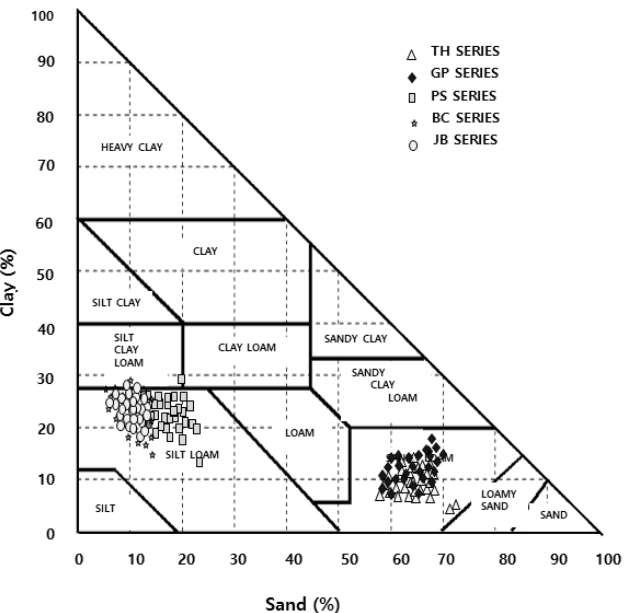
Figure 3. Soil textural distribution of the data set used for estimating the PTFs for five soil series in the RTFS. TH, Taeahn soil series; GP, Gwangpo soil series; PS, Poseong soil series; BC, Bokchun soil series; JB, Junbook soil